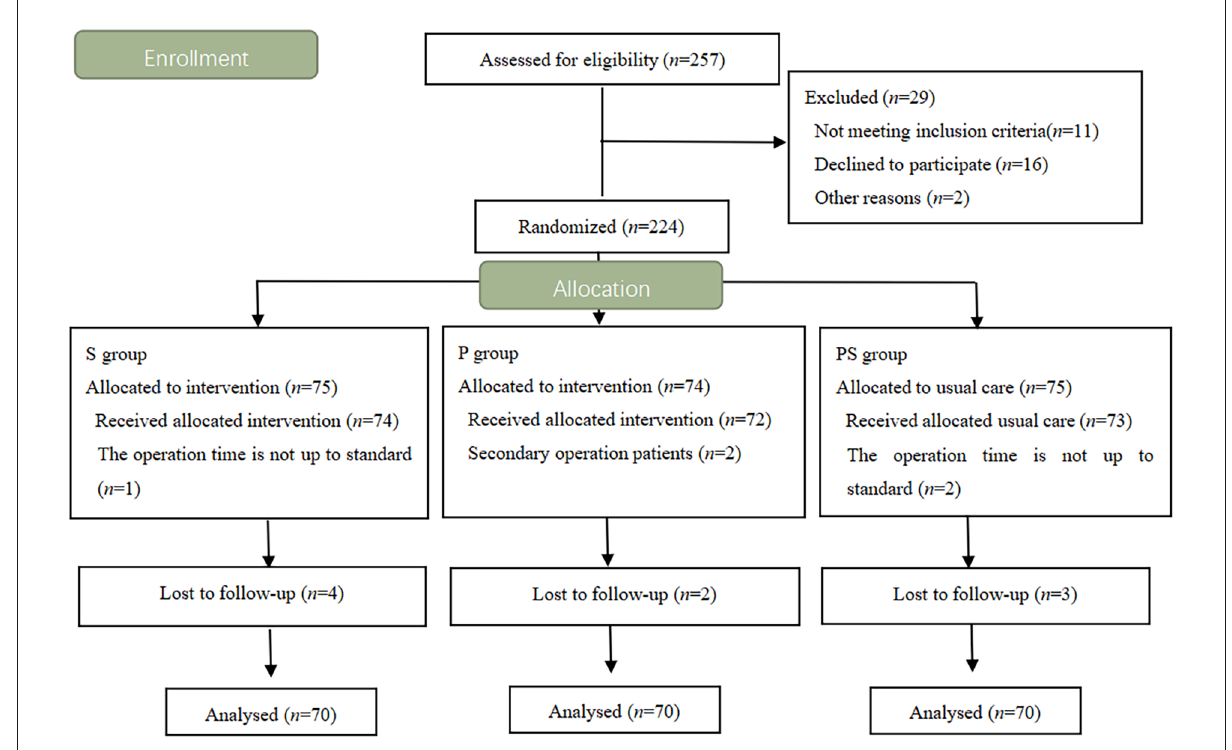
FIGURE1 Flow chart of patients included in the